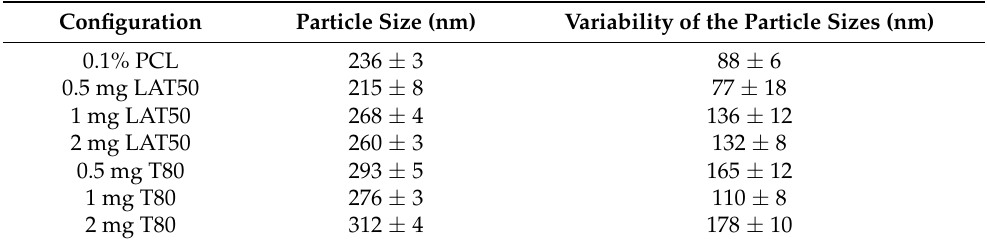
Table 4. Influence of the concentration of nonionic surfactants dissolved in the organic phase (Y-mixer).